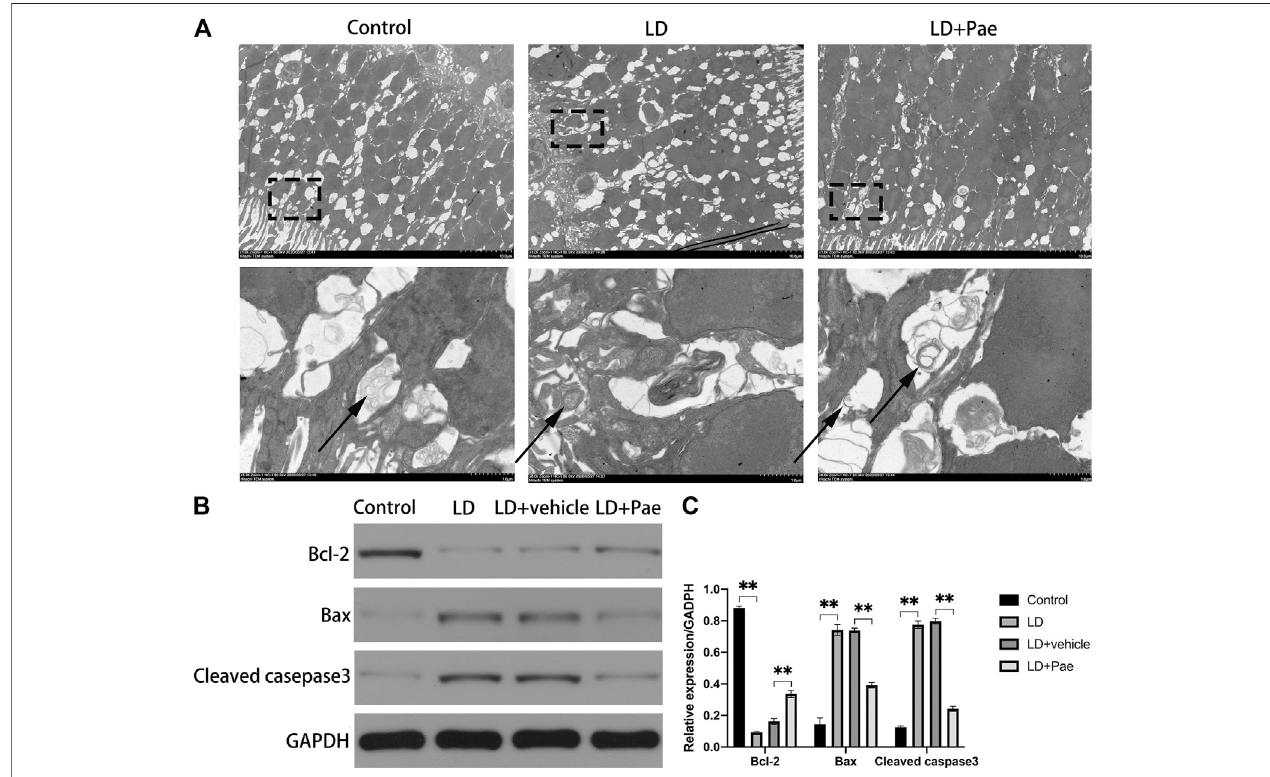
FIGURE 3 | Effect of Pae on ultrastructural structure of autophagosome on RPs of each group and apoptosis of retina. (A) Ultrastructural structure of autophagosome formationofeach group. (B,C) ExpressionofBaxand Cleaved casepase3 protein weredecreased, while expression ofBcl-2 proteinwasupregulated three days after light damage. Autophagosomes were pointed by arrows. Data show mean ± SD. ( n (cid:1) 6 – 9 for each group) ** p < 0.01.